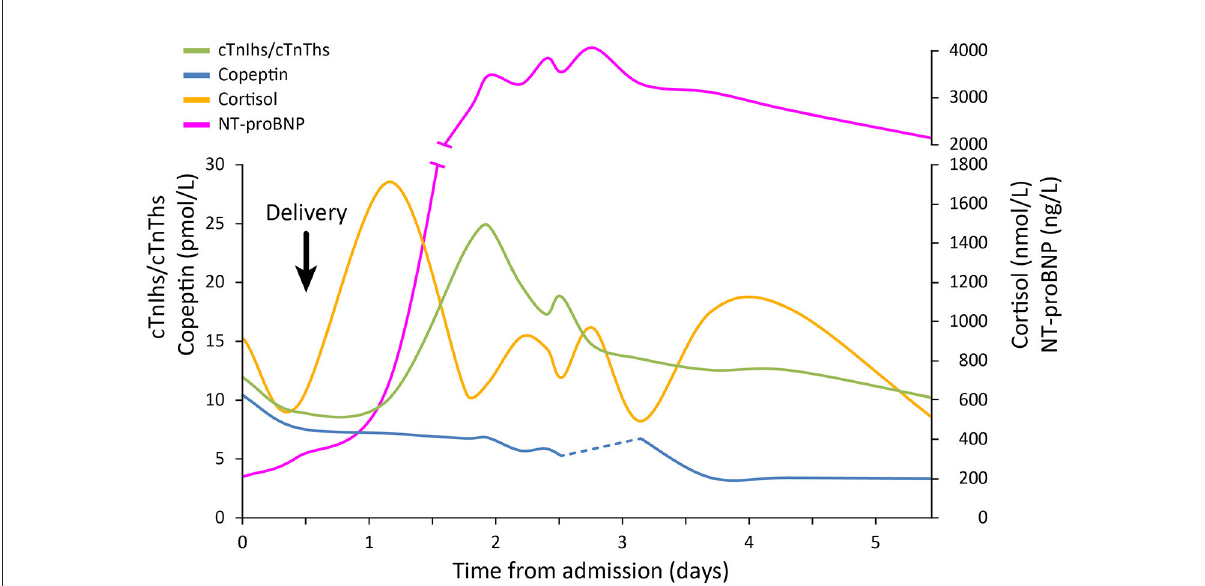
FIGURE1 Changes in stress hormones and cardiac biomarkers during Takotsubo syndrome. Concentrations of circulating stress hormones and cardiac biomarkers were measured upon admission to hospital (day 0) and at intervals until day 5. The patient delivered her baby between day 0 and day 1 after admission. Ratio of cTnIhs/cTnThs was calculated from individual results expressed in